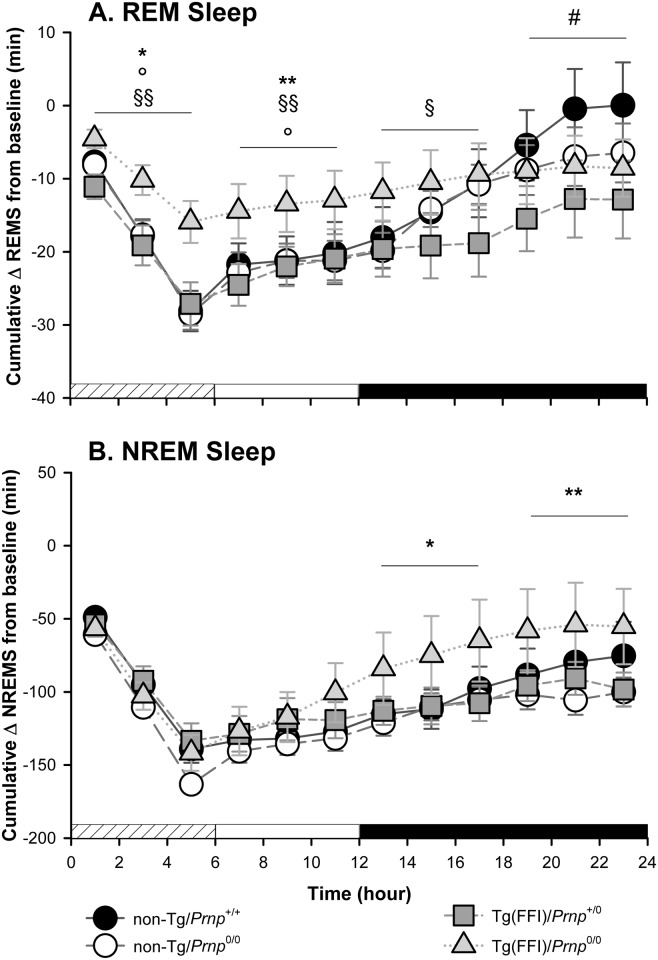
Tg(FFI) mice show an altered response to sleep deprivation.Time course of the loss and recovery of time spent in rapid eye movement (REM) (A) and non-rapid eye movement (NREM) (B) sleep, during and after sleep deprivation. Values were from 8 non-Tg/Prnp
+/+, 10 non-Tg/Prnp
0/0, 9 Tg(FFI-26)/Prnp
0/0 and 8 Tg(FFI-26)/Prnp
+/0. Mice were kept awake during the first 6 h of the light phase (crosshatched bar) by gentle handling, and allowed to sleep freely in the next 18 h. The black bar indicates the dark portion of the light-dark cycle. REM and NREM sleep were calculated hourly for each animal as the difference between the amount of time spent in a given state (REM or NREM sleep) during and after sleep deprivation, and the amount spent in the corresponding hour during baseline conditions (undisturbed). The hour-by-hour differences were then summed to obtain a cumulative curve. Data (means ± SEM) are presented in 2-h intervals. Single symbols: p < 0.05; double symbols: p < 0.01. *, Tg(FFI-26)/Prnp
0/0 vs non-Tg/Prnp
0/0; °, Tg(FFI-26)/Prnp
0/0 vs. non-Tg/Prnp
+/+; §, Tg(FFI-26)/Prnp
0/0 vs. Tg(FFI-26)/Prnp
+/0; #, Tg(FFI-26)/Prnp
+/0 vs. non-Tg/Prnp
+/+. A mixed model analysis of variance for repeated measures was done on 6 h blocks. Between-strains post-hoc comparisons by one-way ANOVA with Bonferroni correction: (panel A) 0–6 h: F3,101 = 4.98, p = 0.003; 7–12 h: F3,101 = 5.25, p = 0.002; 13–18 h: F3,101 = 2.88, p = 0.05; 19–24 h: F3,101 = 3.30, p = 0.023. (panel B) 0–6 h: F3,101 = 1.01, p = 0.391; 7–12 h: F3,101 = 1.78, p = 0.156; 13–18 h: F3,101 = 3.76, p = 0.013; 19–24 h: F3,101 = 3.97, p = 0.010.